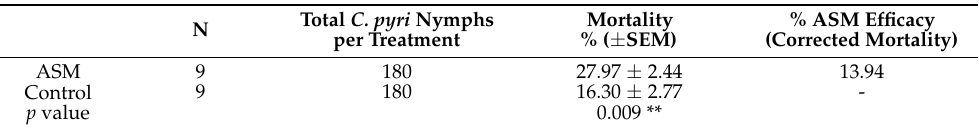
Table 5. Mortality data of C. pyri nymphs on ASM-sprayed pear plants ( N = 9) compared to control plants ( N = 9) and percentage of ASM efficacy (corrected mortality) calculated according to [34]. ** p < 0.01 vs. control according to the Mann-Whitney